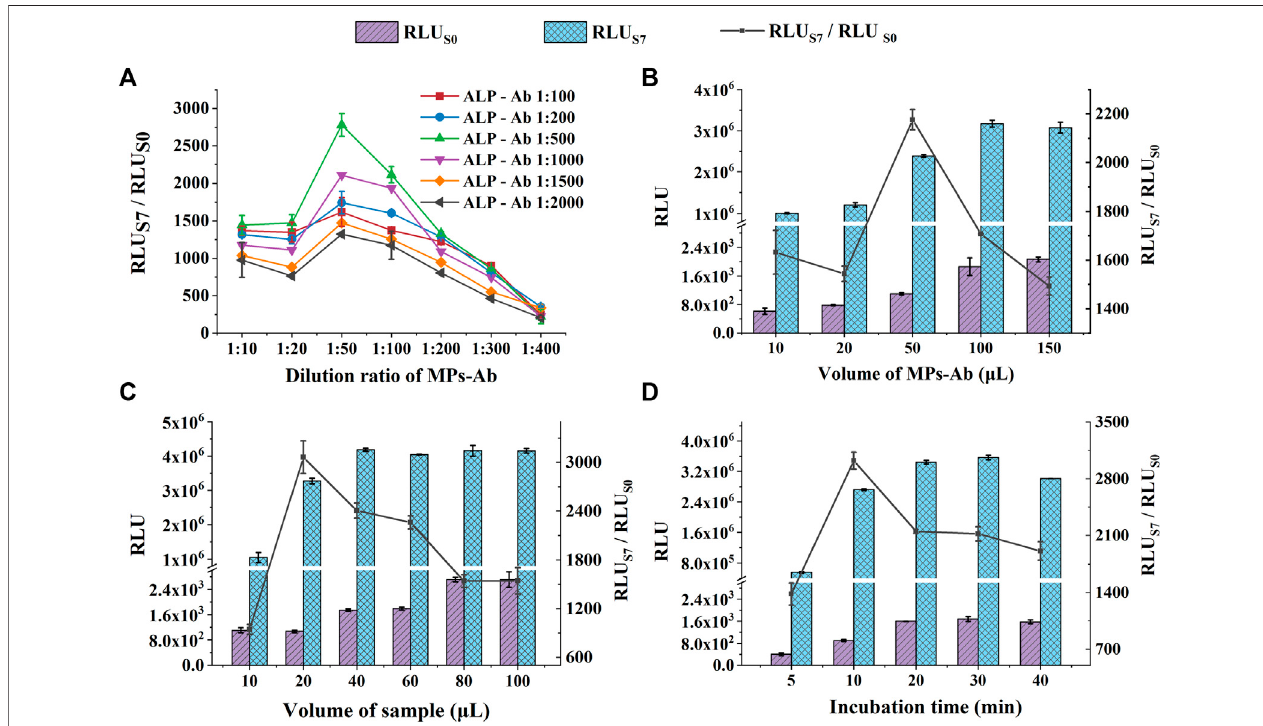
FIGURE3| Optimization ofexperimental conditionsfor CA50 detection: thedilutionratioofMPs-Ab and ALP-Ab (A) ; thevolume ofMPs-Ab (B) ;the volume ofthe sample (C) ; and incubation time (D) . The concentrations of S0 and S7 used in these experiments were all 0 U ml − 1 and 200 U ml − 1 , respectively.